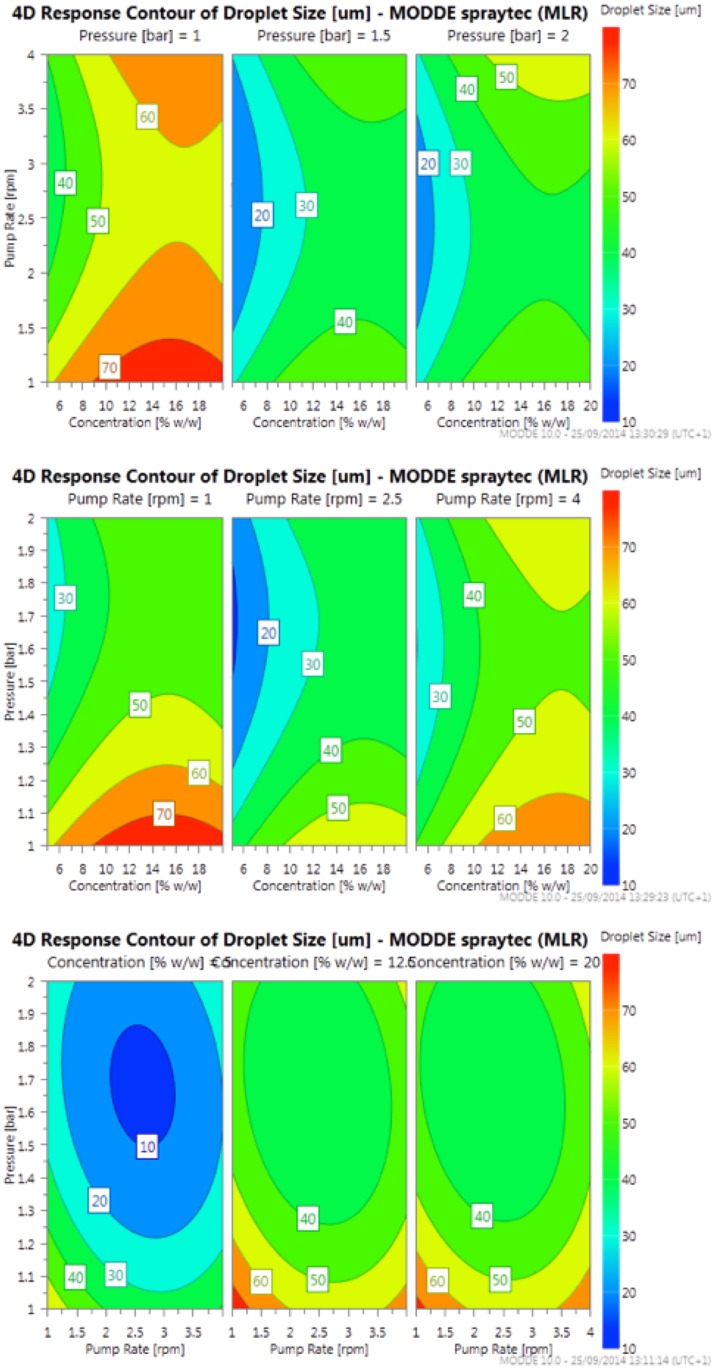
Response contour plot with respect to fixed levels of atomisation pressure, pump rate and polymer concentration.